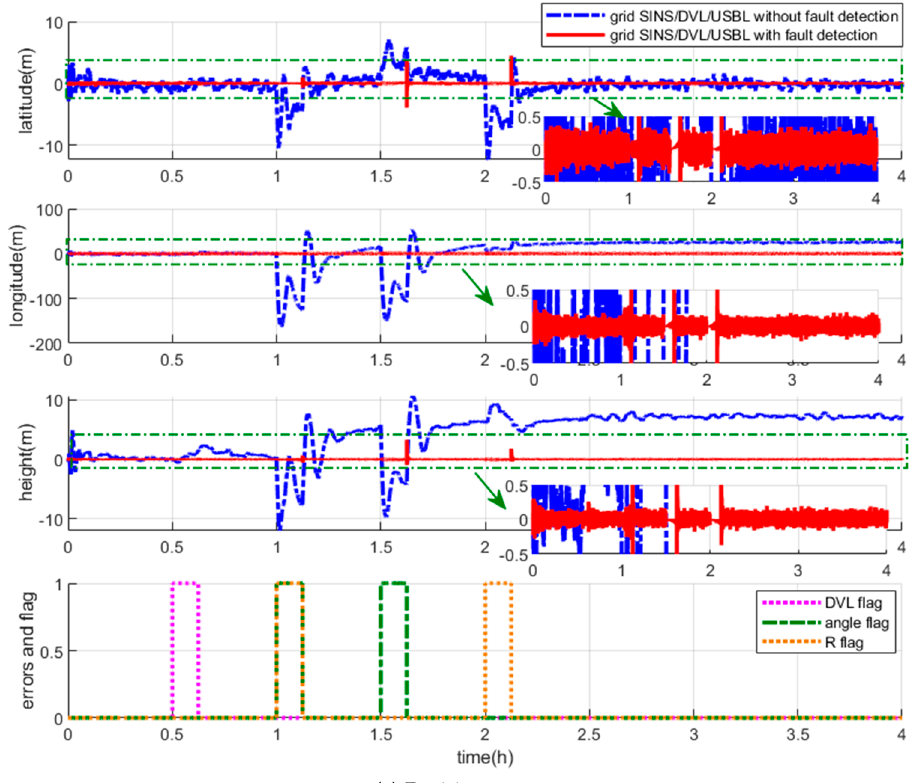
Figure 7. Description of the grid SINS/DVL/USBL integrated navigation errors with and without the fault detection.